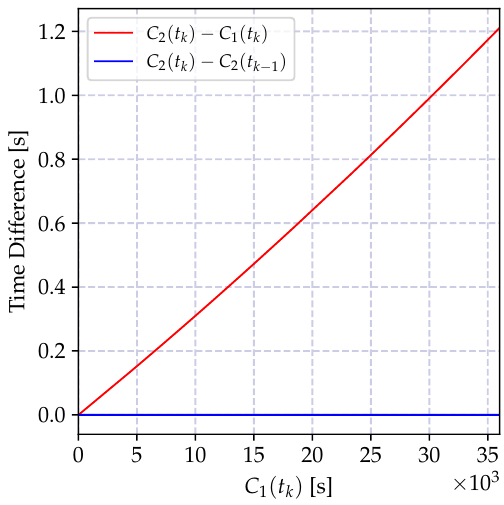
Figure 6. The time difference in seconds between the simulated local clock C 2 ( t k ) and the reference time reports C 1 ( t k ) delivered through a Gaussian message delivery delay which are associated with the universal time t k